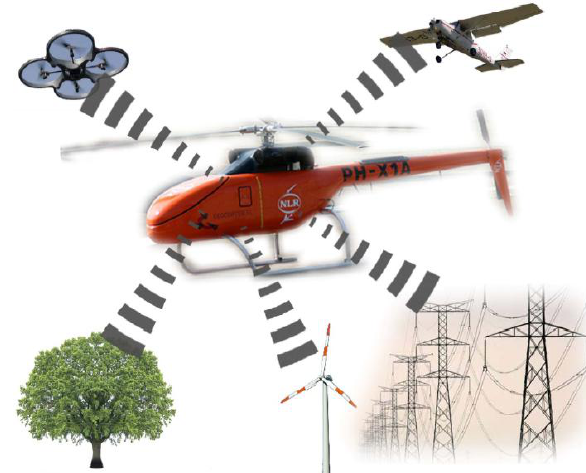
Figure 9. Detect-and-avoid